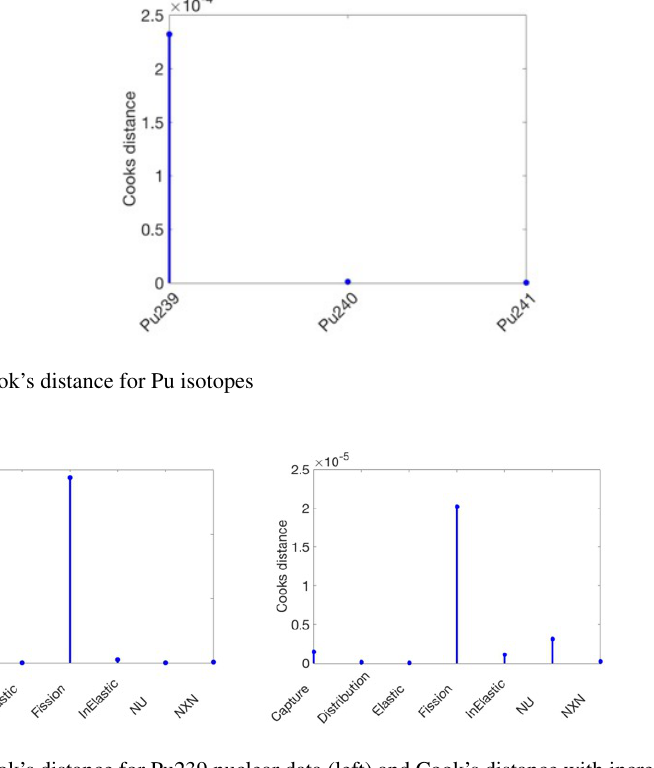
Figure 2. Cook’s distance for Pu239 nuclear data (left) and Cook’s distance with increased uncertainty in the prior ¯ ν